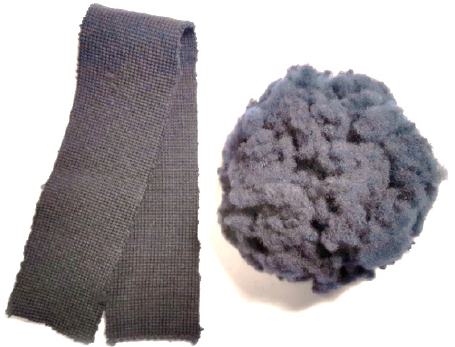
Figure 1. Merino wool, pre and post-carding process.